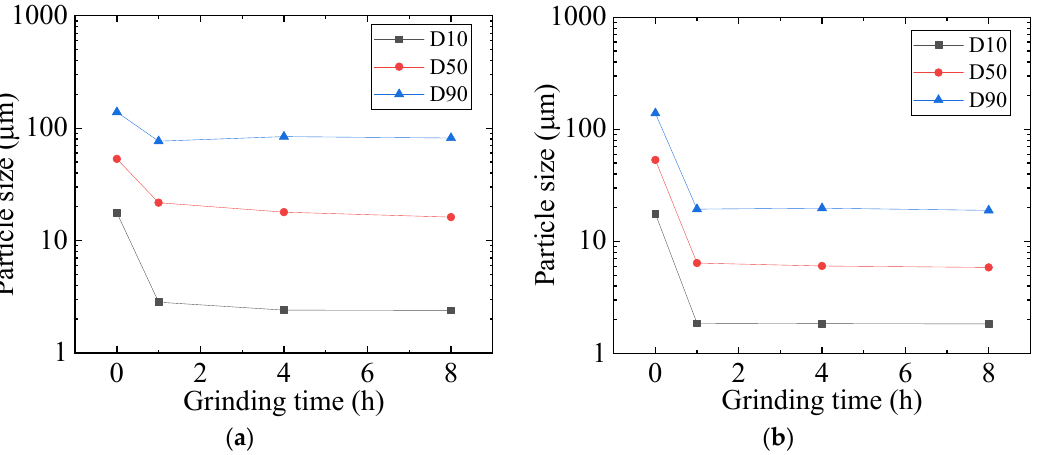
Figure 5. The effect of grinding time on the d10, d50 and d90 diameter of dry and wet ground samples; ( a ) dry grinding; ( b ) wet grinding.